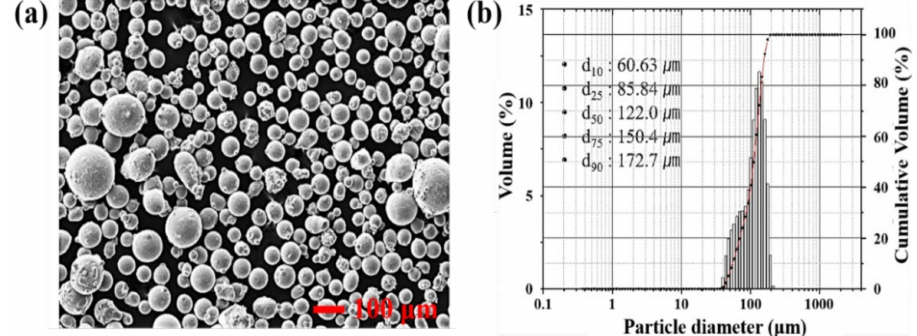
Figure 1. ( a ) Appearance morphology, and ( b ) particle size distribution of Fe-Cr-Si